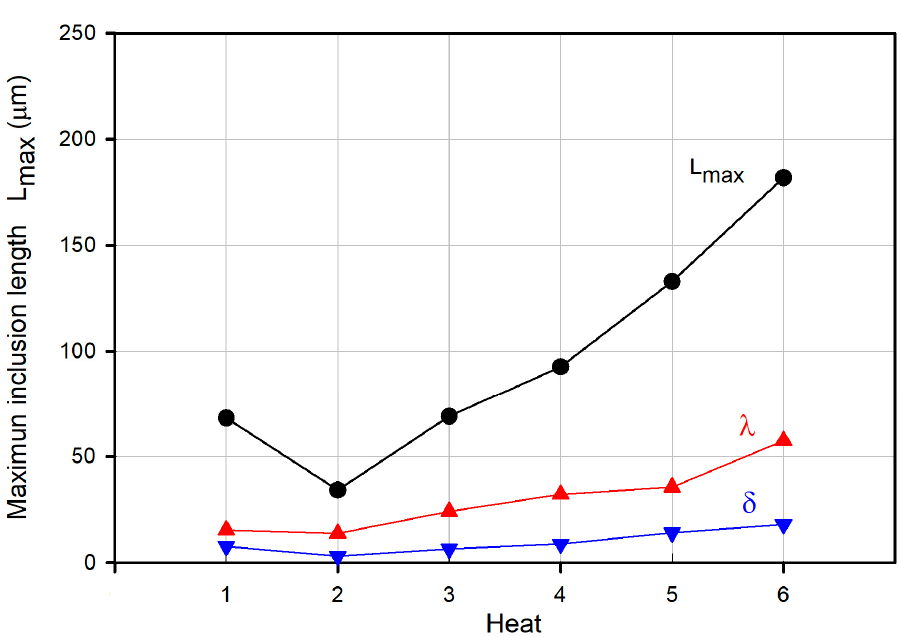
Figure 11. Maximum inclusion size L max , λ , and δ for all heats.